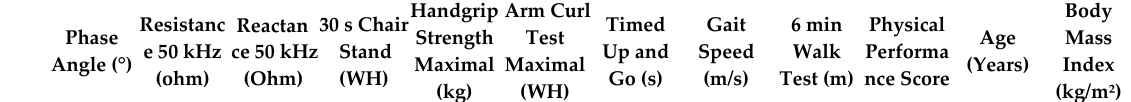
Table 4. Association between the BIA raw parameters, physical performance, age, BMI and nutrient intake.